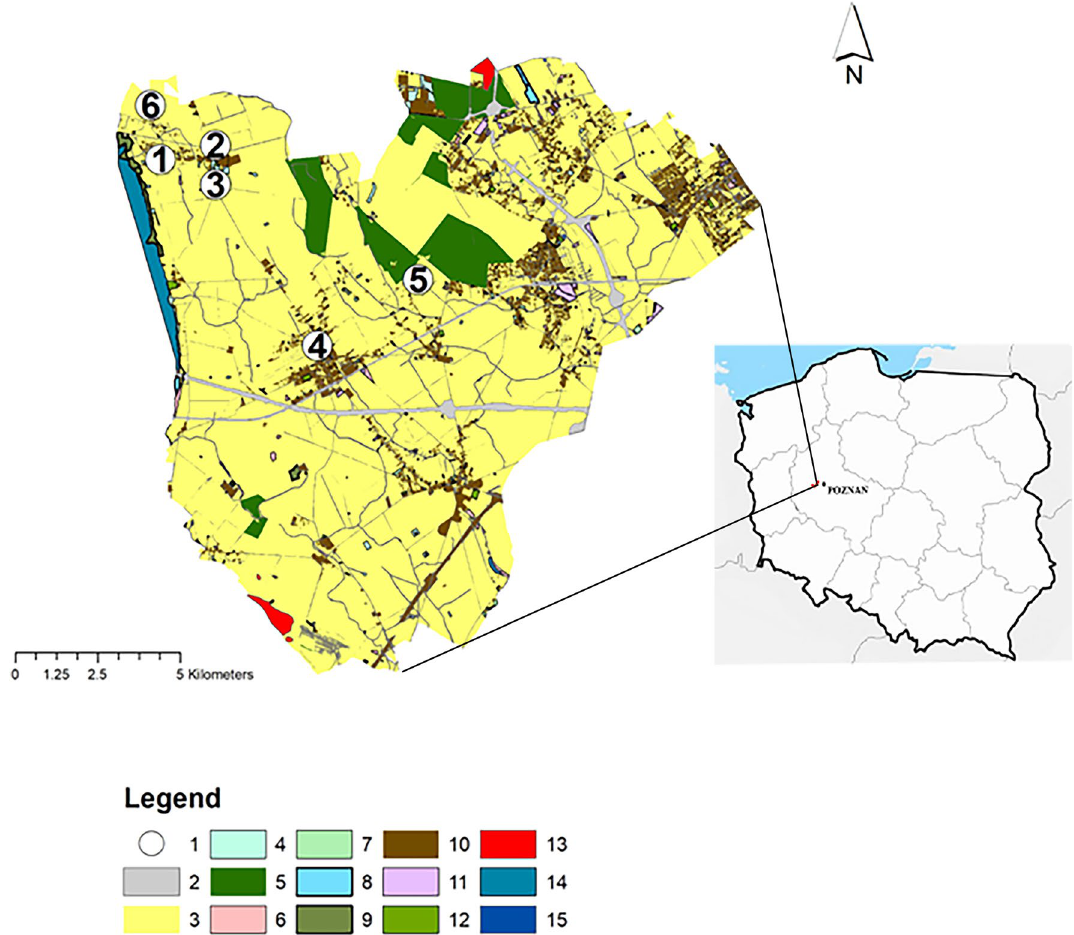
Figure 1. The location of the waterbodies (according to Szpakowska et al. 23 , changed). The map was generated by ArcGIS 10.6. https:// suppo rt. esri. com/ en/ Produ cts/ Deskt op/ arcgis- deskt op/ arcmap/ 10-6- 1# overv iew. Explanations: 1—waterbodies, 2—roads, 3—arable land, 4—bushy land, 5—forests, 6—wasteland, 7—orchards,